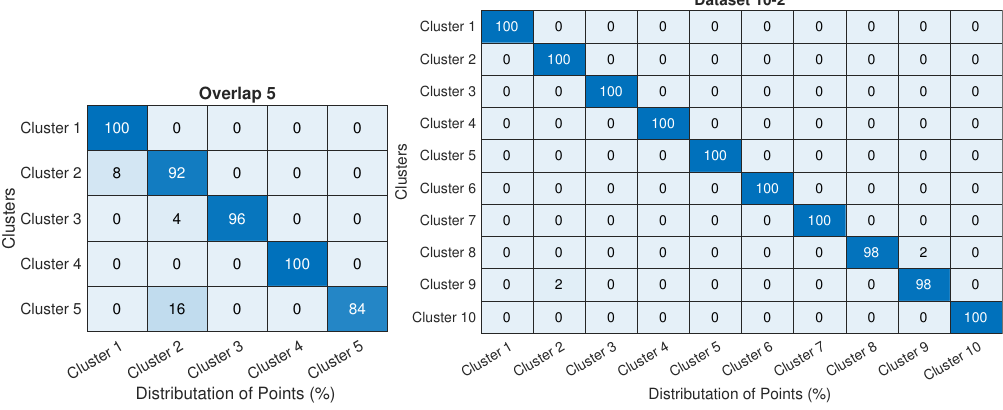
Figure 10. Cluster analysis for 2